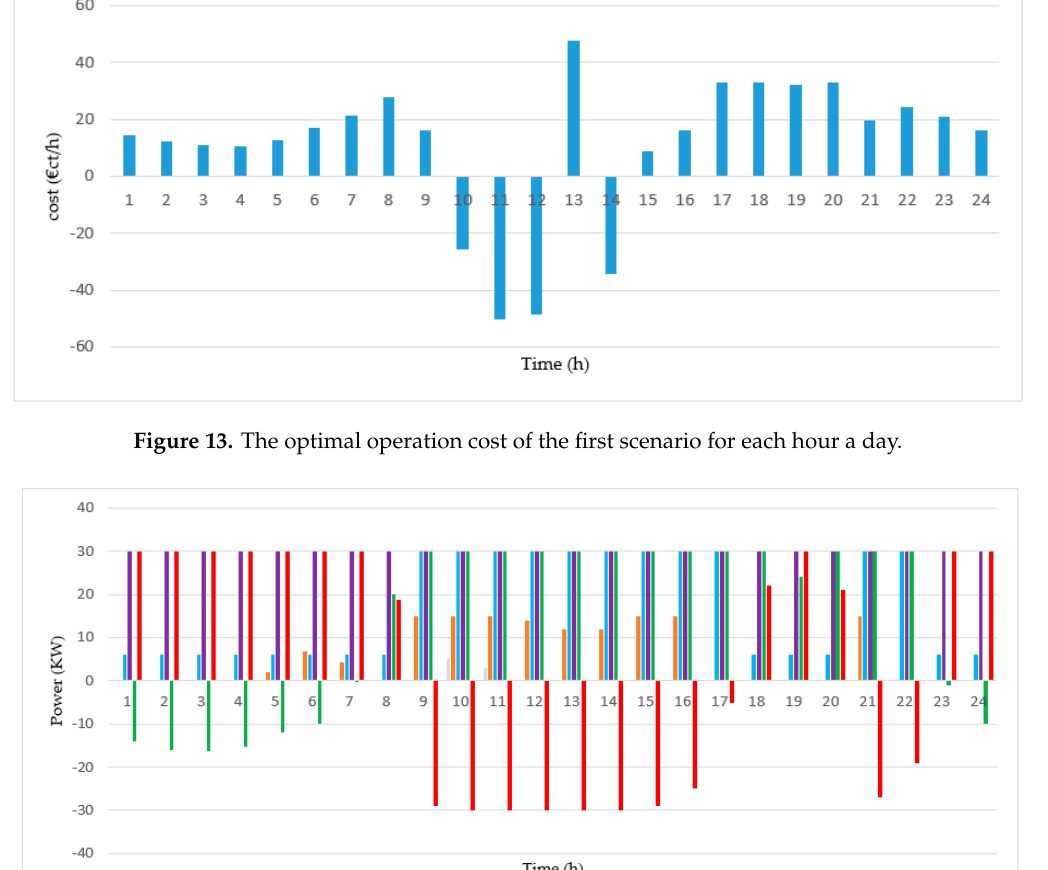
Figure 14. The optimal output power from the installed DG units for the second scenario.